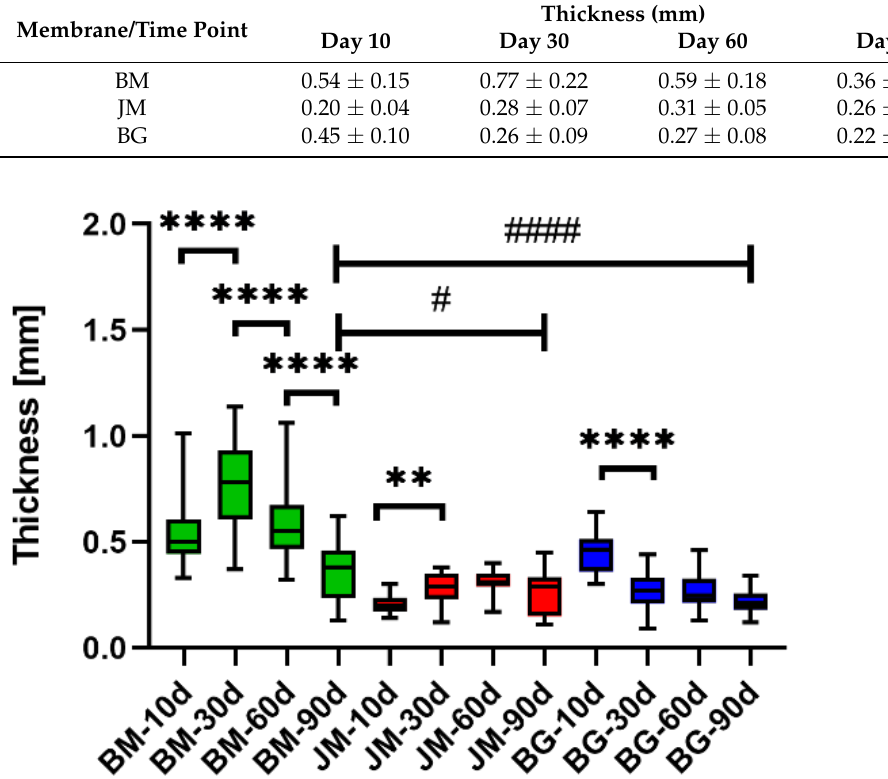
Figure 4. Results of the histomorphometrical measurements of the membrane thickness (* = intrain- dividual differences, # = interindividual differences; # p < 0.05, ** p < 0.01 and ****/#### p < 0.0001).